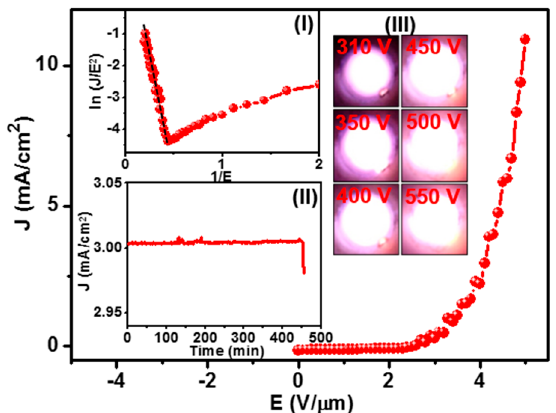
Figure 1. Field electron emission properties (current density-applied field, J - E , curve). Inset I shows the corresponding Fowler–Nordheim (F–N) plot, inset II shows the life-time stability measurement ( J -time curve) for NCD films grown on Cr-coated LNO (NCD/Cr/LNO films, while inset III shows the plasma illumination (PI) images versus voltage applied to the microplasma devices using NCD/Cr/LNO films as cathode materials.